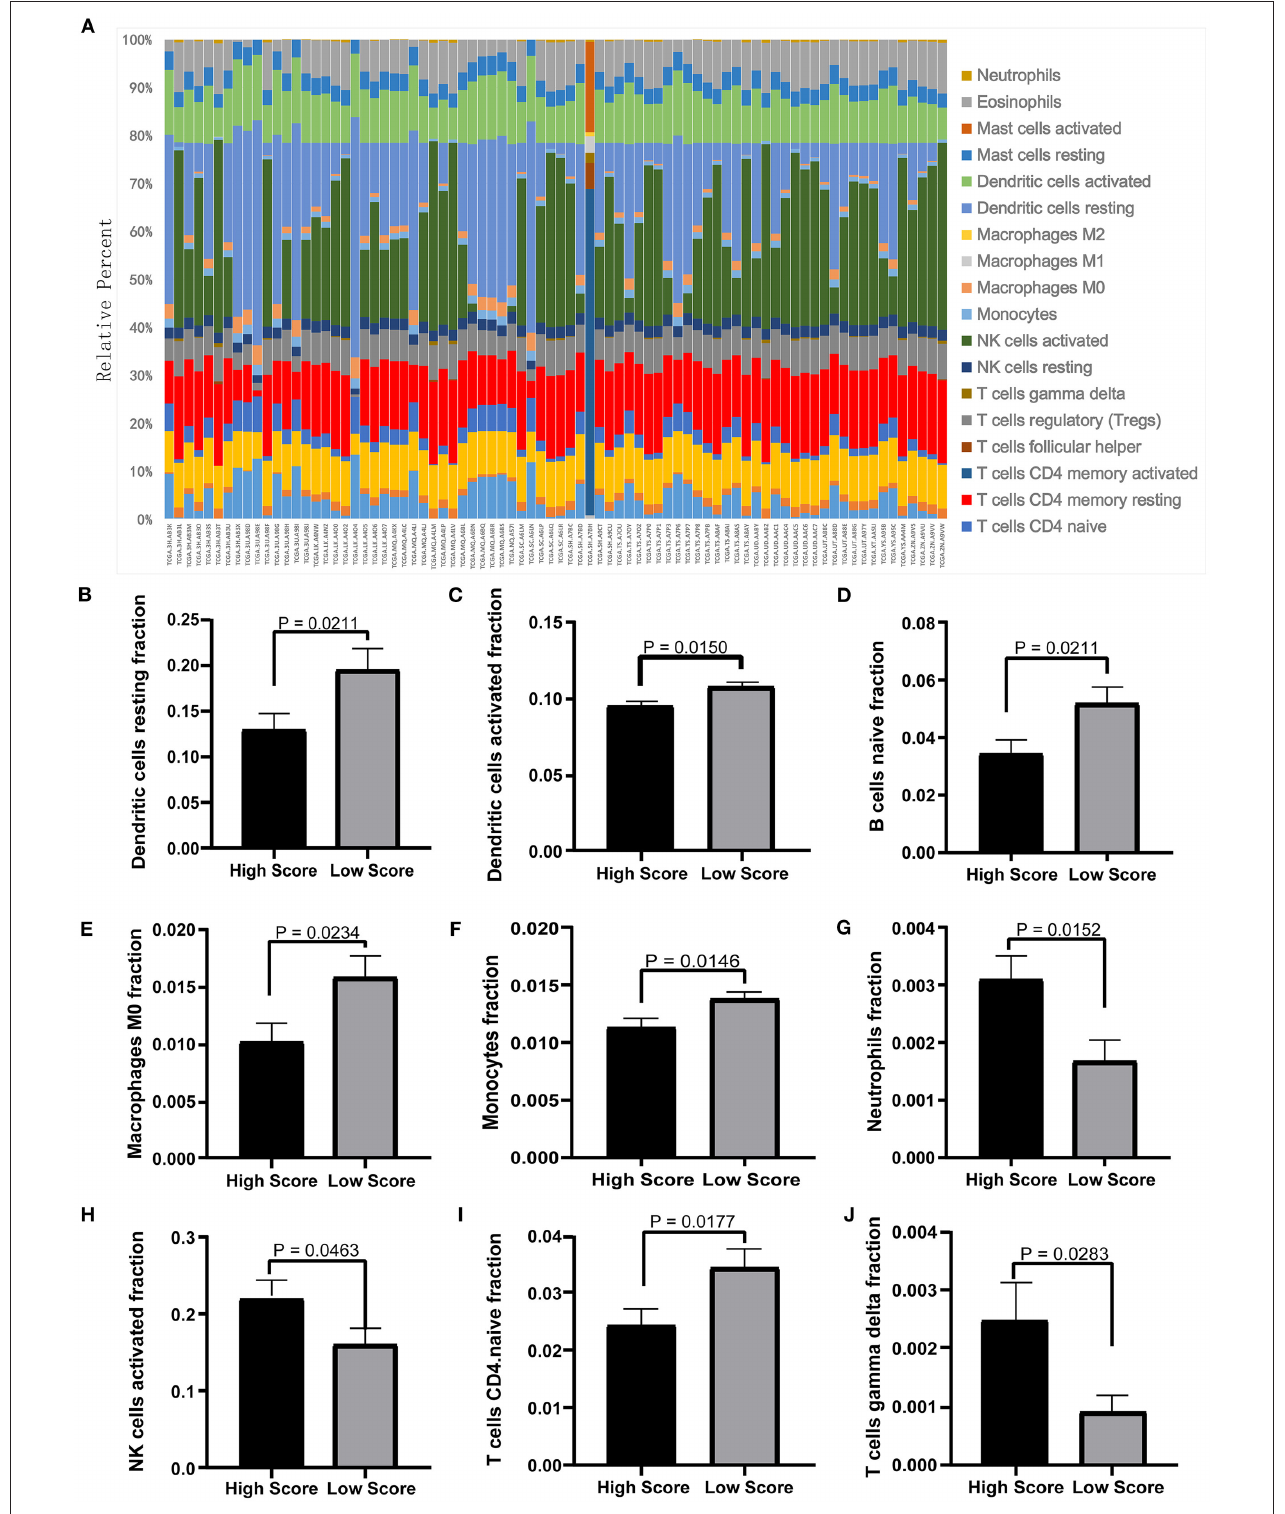
FIGURE 10 | Twenty-two types of immune-cell infiltration analyses. (A) The overall changes of 22 types of immune cells in the MPM tissues of the 80 patients. (B–J) The significant differences of the immune cells between the high- and low-score groups based on the Student’s t- test.